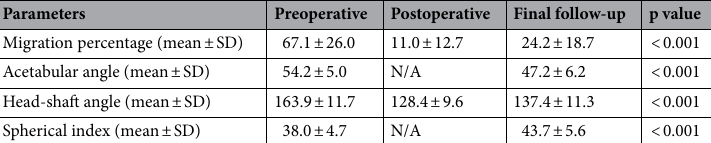
Table 3. Changes in the radiographic parameters.